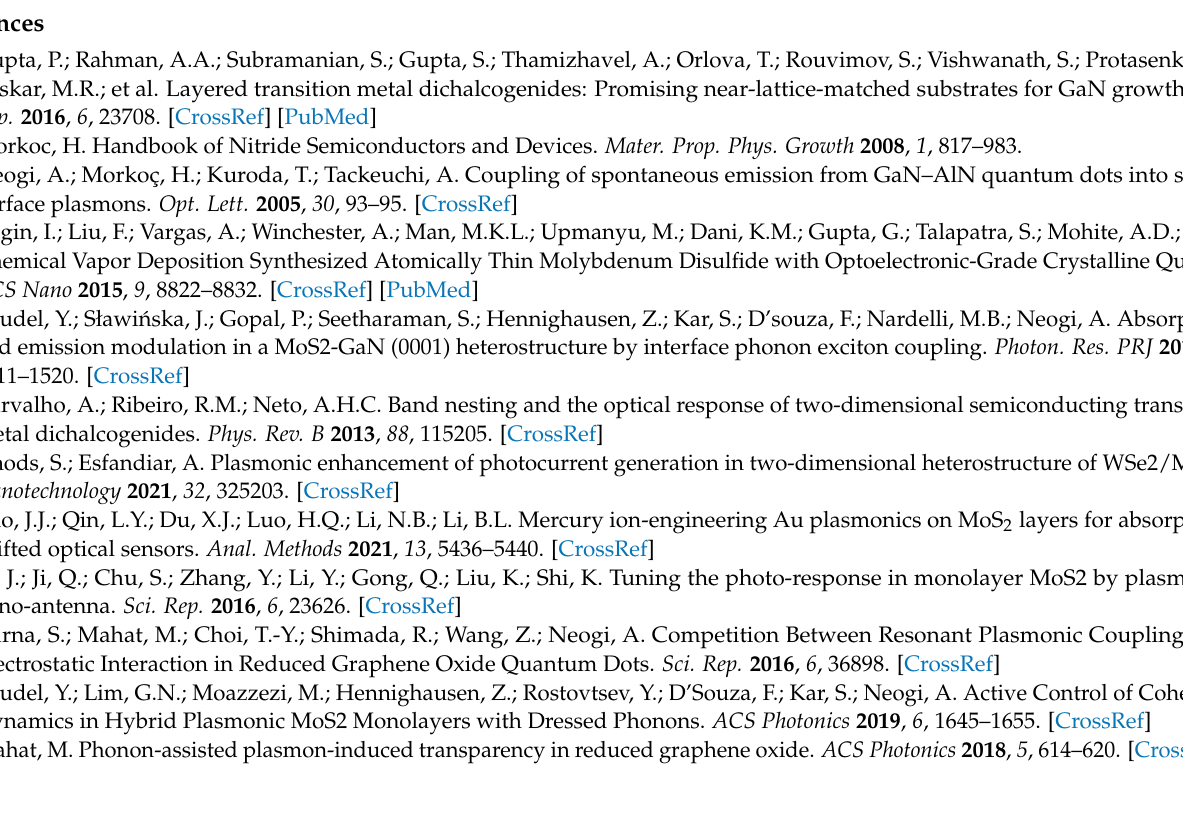
MoS 2 on GaN. Figure S2: Decay kinetics probed at (a) A excitonic band and (b) B excitonic band of MoS 2 for MoS 2 on quartz (black), MoS 2 -GaN (red), Au-MoS 2 -GaN (blue) and Pt-MoS 2 -GaN (pink) measured with 3.54 eV pump excitation. Figure S3: Decay kinetics probed at (a) A excitonic band and (b) B excitonic band of MoS 2 for MoS 2 on quartz (black), MoS 2 -GaN (red), Au-MoS 2 -GaN (blue) and Pt-MoS 2 -GaN (pink) measured with 3.06 eV pump